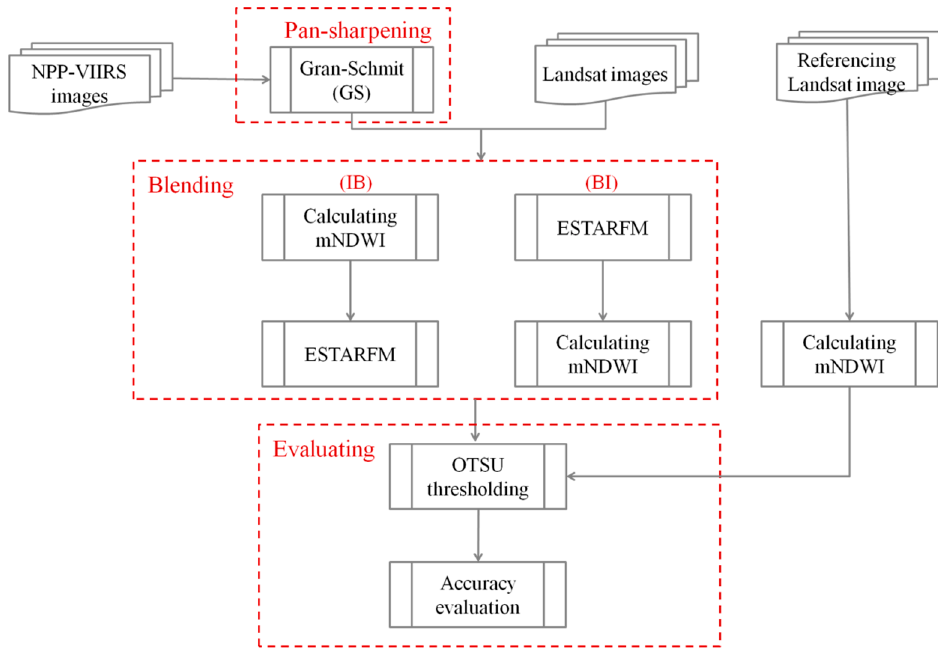
Figure 3. Flowchart of methodology.